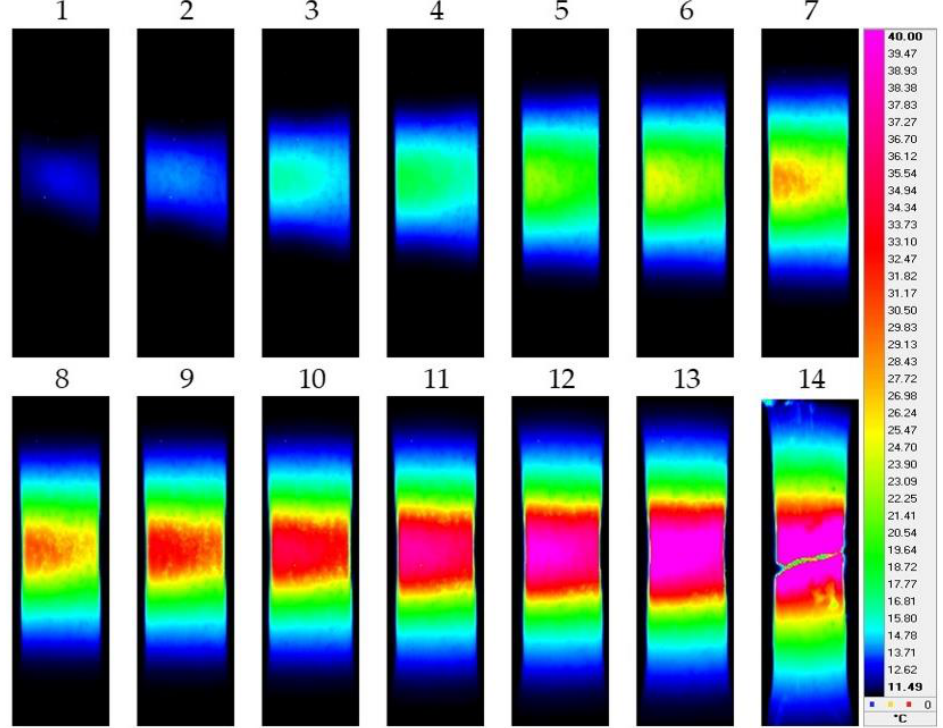
Figure 5. IR thermograms of deformed sample of the Ti-45Nb alloy in the CG state: 1 —ε = 0.065; 2 — ε = 0.07; 3 —ε = 0.075; 4 —ε = 0.08; 5 —ε = 0.09; 6 —ε = 0.1; 7 —ε = 0.11; 8 —ε = 0.12; 9 —ε = 0.13; 10 —ε = 0.135; 11 —ε = 0.14; 12 —ε = 0.15; 13 —ε = 0.155; 14 —ε = 0.16.